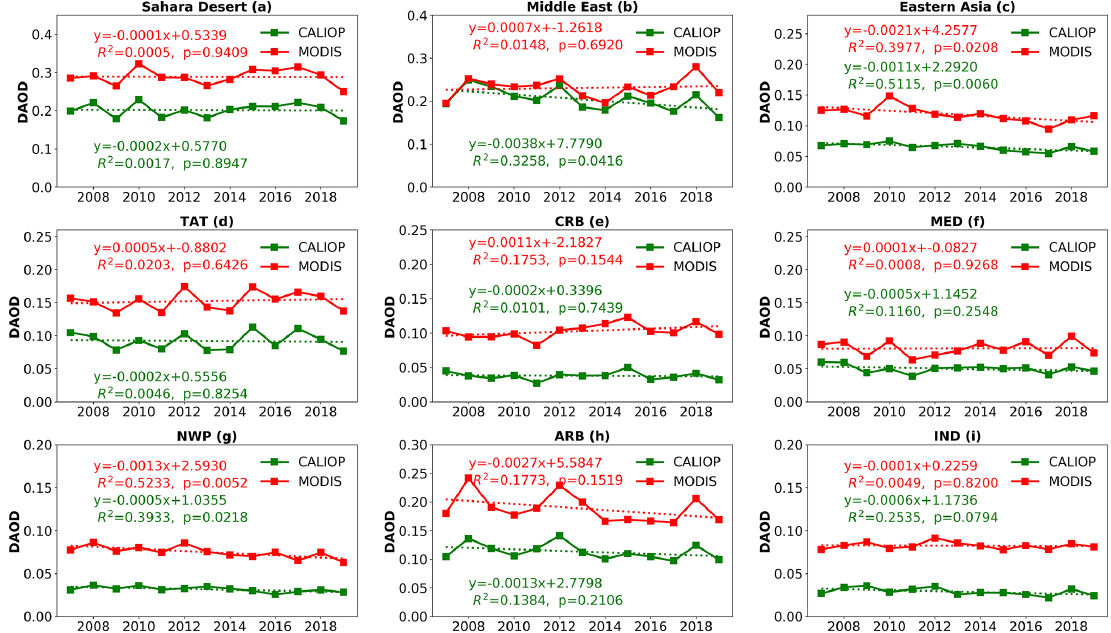
Figure 15. DAOD interannual variability over main dust source regions (a–c) and dust outflow regions (d–i) revealed by CALIOP (green curve) and MODIS (red curve)